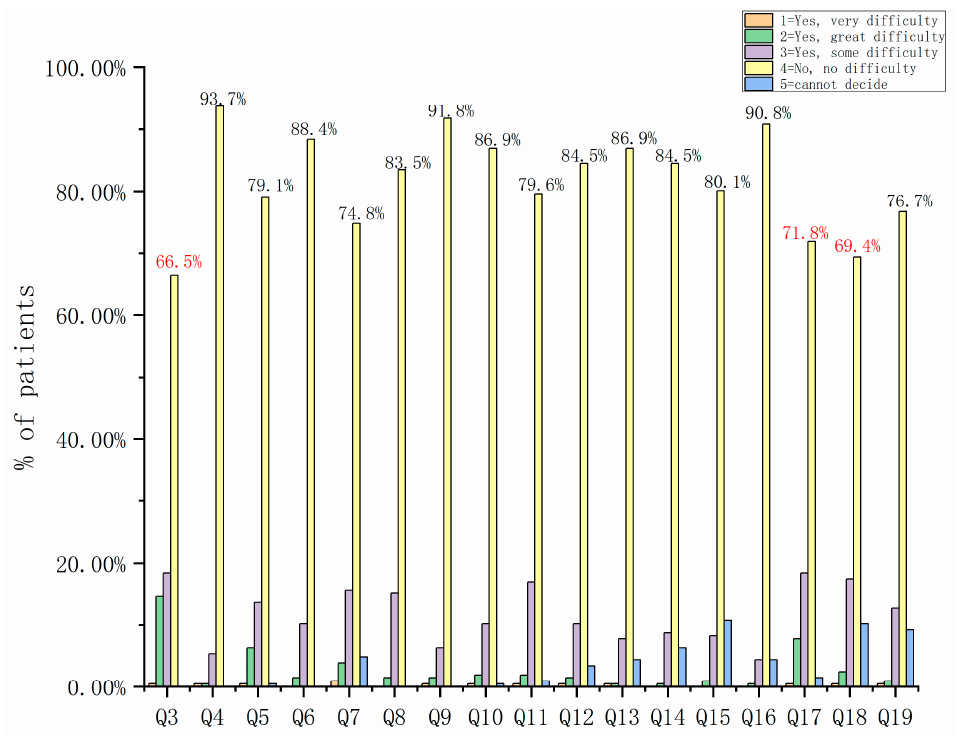
Figure A1. Cumulative monocular distance, intermediate, near uncorrected visual acuity, and best corrected visual acuity at 3 months postoperatively (* means significant differences were found be- tween the two groups).